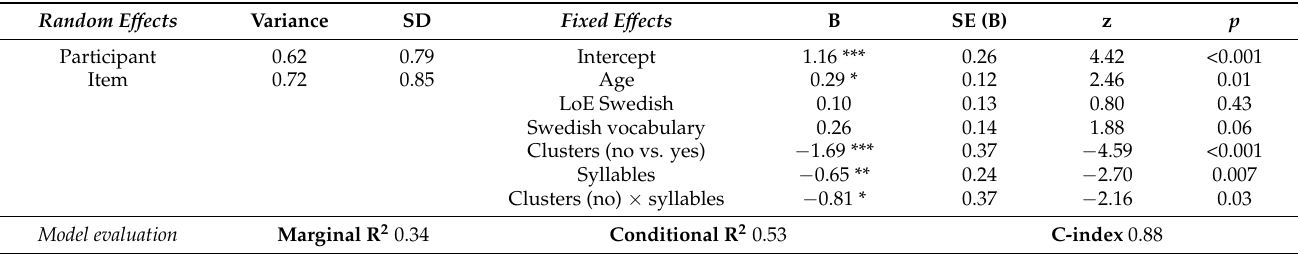
Table 9. Summary of Model 6: accuracy, LS-Swe task.